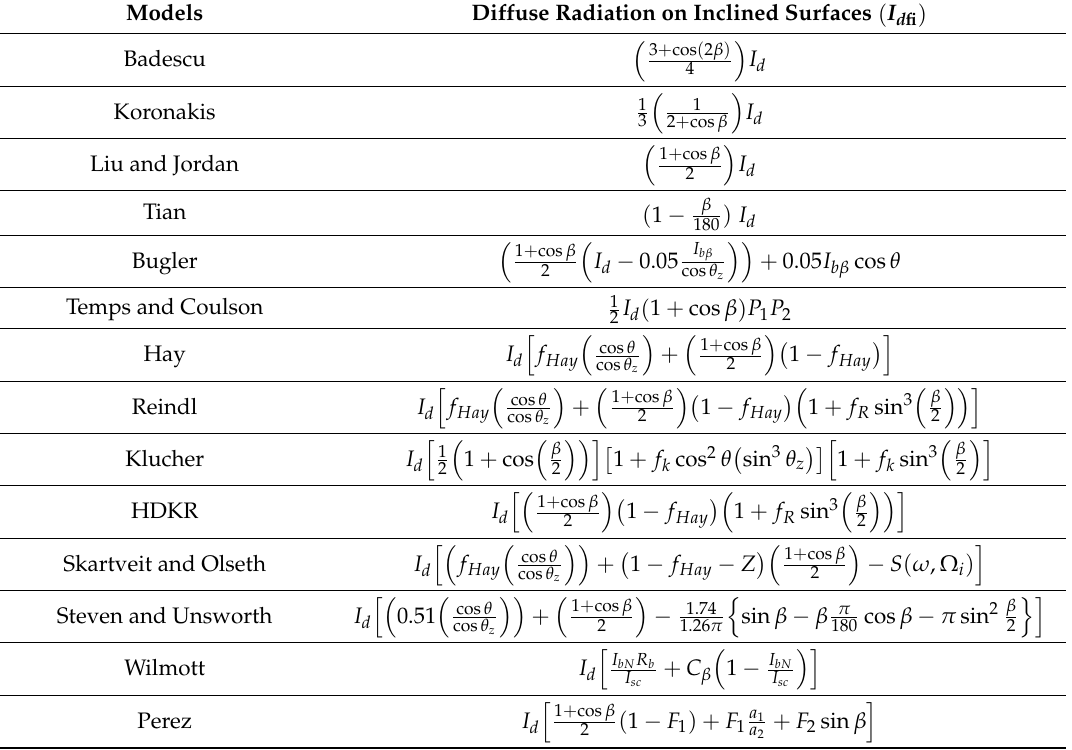
Table 6. Summary of diffuse models on inclined